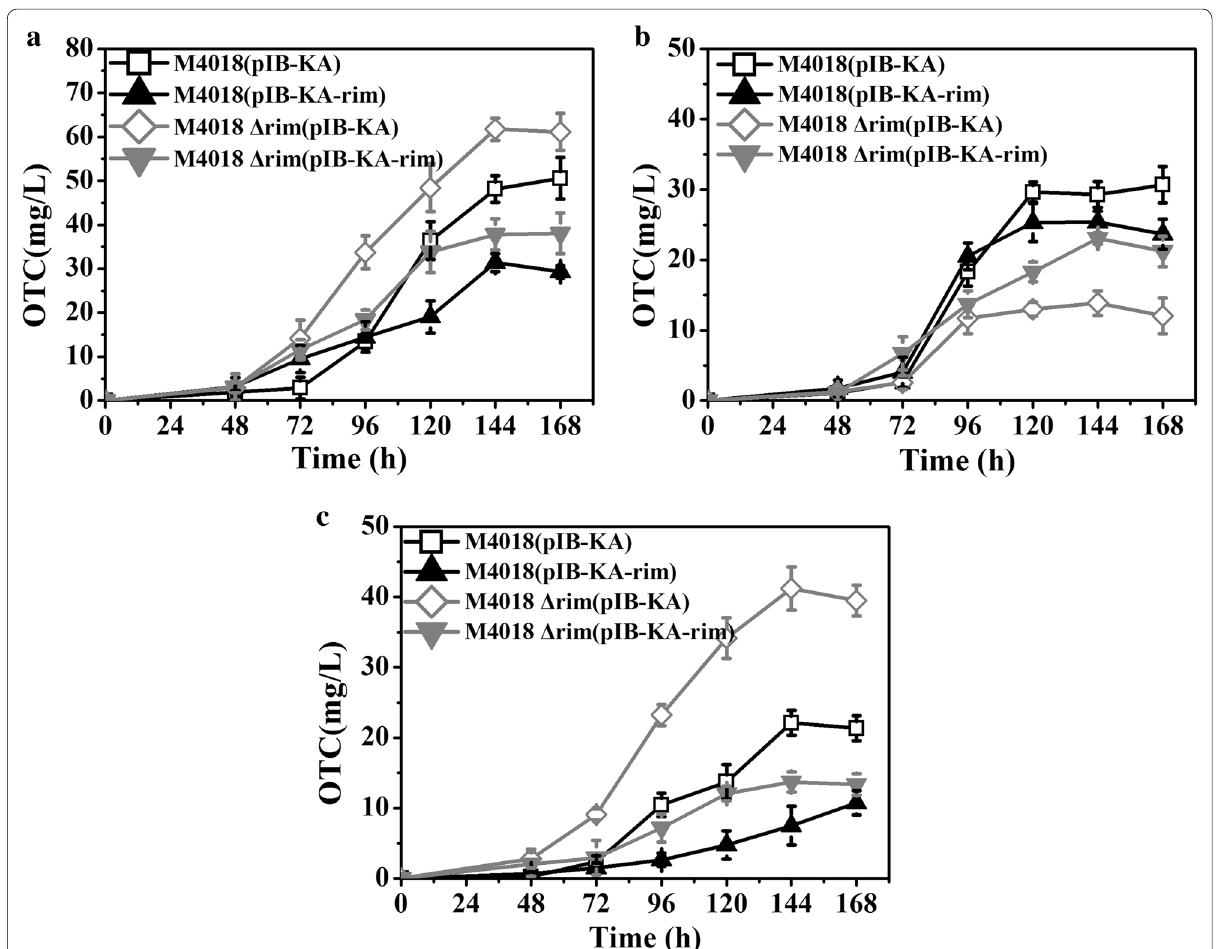
Fig. 6 OTC production by M4018 (pIB-KA) (white square), M4018 (pIB-KA-rim) (black up-pointing triangle), M4018 Δrim (pIB-KA) (white diamond) and M4018 Δrim (pIB-KA-rim) (black down-pointing triangle) cultivated on MM with 50 mM Gly ( a ), MM with 50 mM Gly and 0.1 M KCl ( b ) or MM